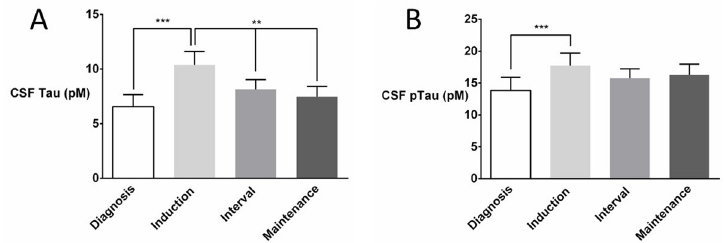
Fig 1. After an initial rise during the induction phase, CSF levels of Tau (A), but not those of pTau (B), declined during subsequent treatment phases. Treatment phases (diagnosis, induction, interval and maintenance) are further detailed in Table 2. Paired-sample t-tests were used for post-hoc comparison of CSF biomarker levels between treatment phases with � p < 0.05; �� p < 0.01; ��� p < 0.001. Data are means with SEM (error